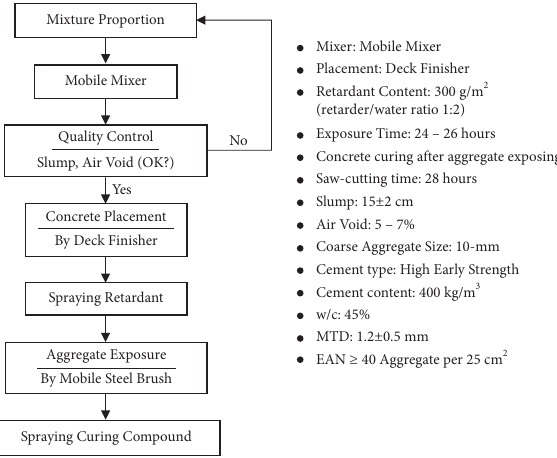
Figure 13: Recommended construction guideline and